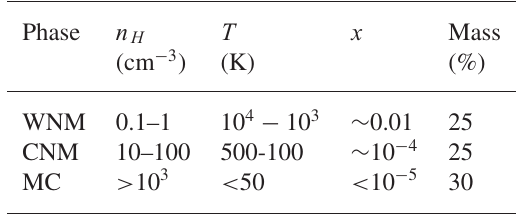
Table 2. Typical conditions in neutral IS clouds with ionization fraction x < 0.1. CNM and WNM stand for Cold and Warm Neutral medium respectively, MC is for Molecular cloud. Estimates of x are from [36]. Mass fractions of the total ISM mass are also